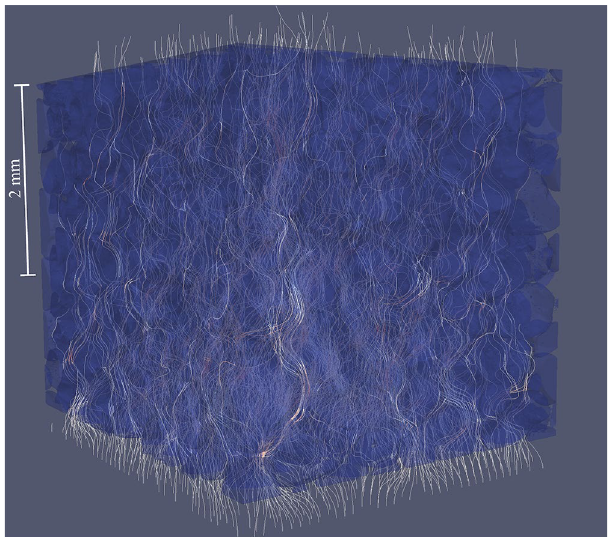
Figure 11. Schematic of streamlines analysis used for tortuosity estimation. Streamlines generated based on pore flow velocity field for the sample 1d (figure created using Paraview 5.3 software https ://www.parav